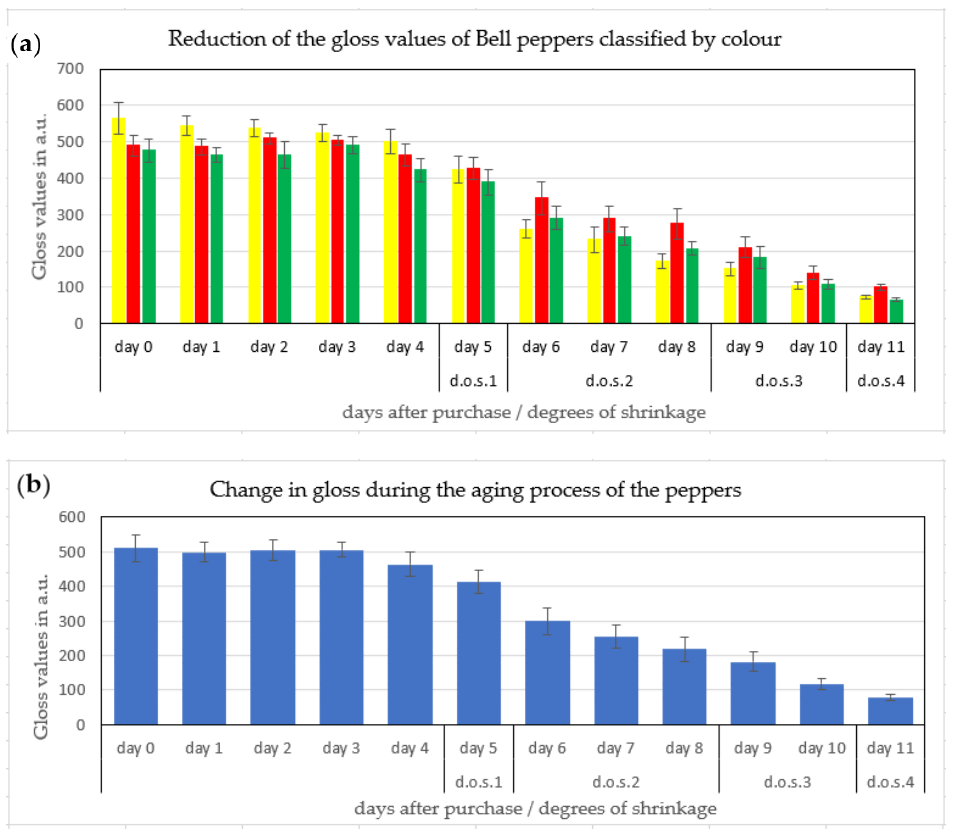
Figure 6. ( a ) Loss of the gloss of bell peppers classified by color (top) (n = 20 per color) and ( b ) aver ‐ aged gloss values per day, stored over 14 days (bottom) (n = 60 pepper fruit per day; ±